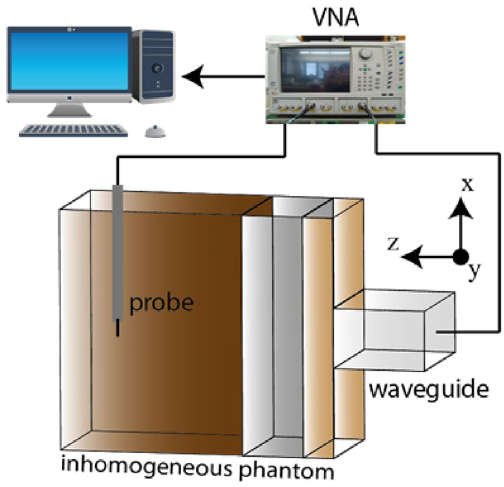
Figure 18. Measurement setup of the power penetration pattern.